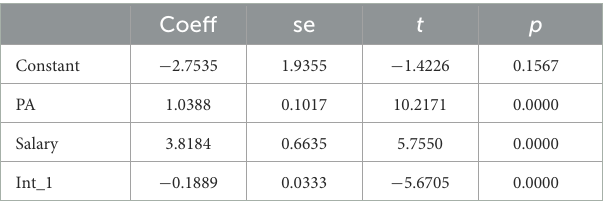
TABLE 5 Genuine acting and personal accomplishment, with social support as the moderator.